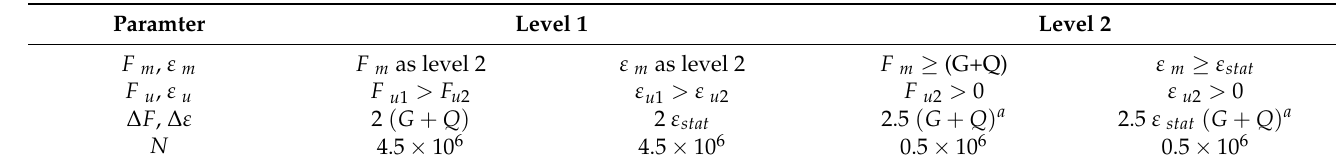
Table 1. Test parameters (requirements) for circular overhead railways with detachable headstocks for grips, suspensions, intermediate structures, cabins or chairs, and seats.